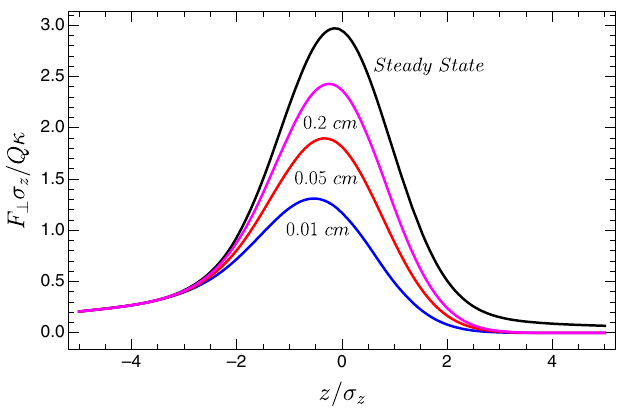
FIG. 4. Transient transverse force on the axis of the beam at the entrance to the bend. The numbers near each curve show the distance from the entrance.